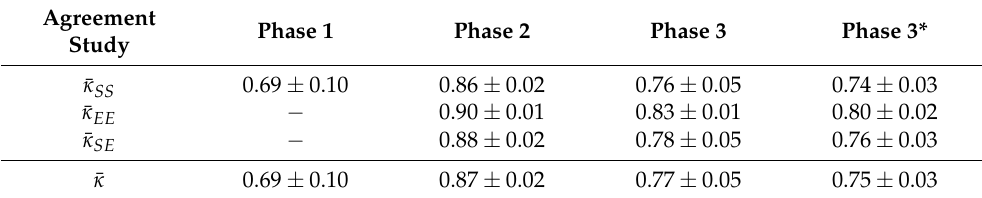
Table 4. Arithmetic means of Cohen’s kappa between different marking